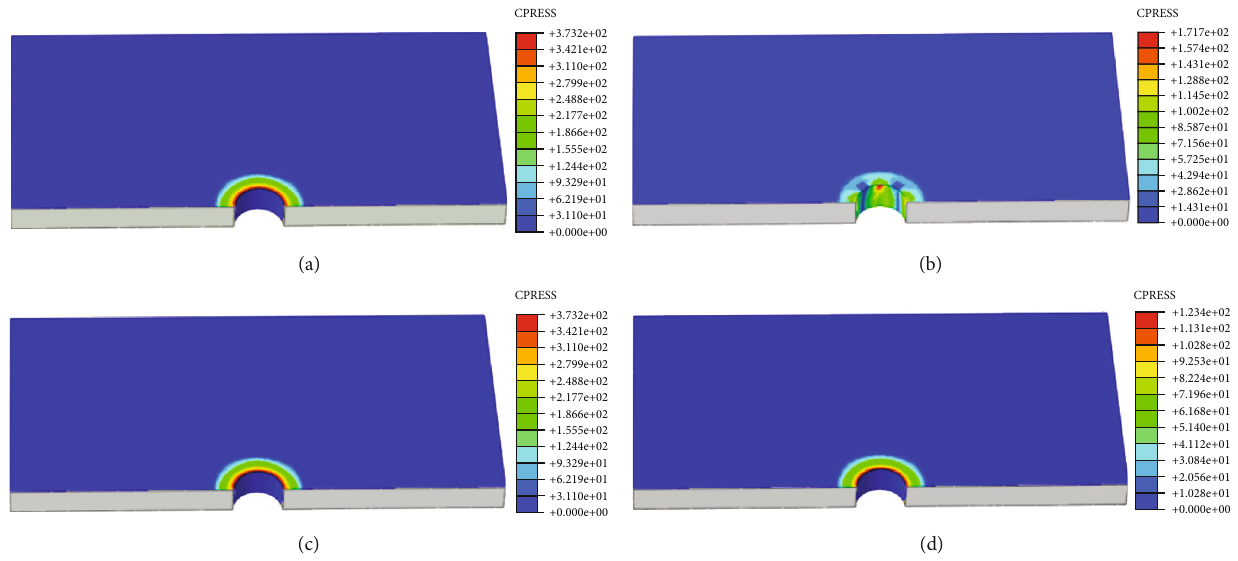
Figure 9: Comparison of contact compressive stress for the joint with 0.4% and 1.2% clearance after applying preload and temperature but not tensile load to the joint. (a) f = 0 : 4 %, T = 25 ° C. (b) f = 0 : 4 %, T = 750 ° C. (c) f = 1 : 2 %, T = 25 ° C. (d) f = 1 : 2 %, T = 750 °